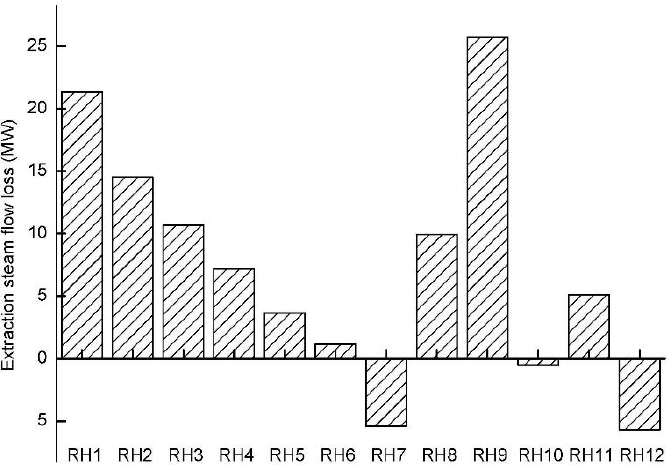
Figure 6. Extraction steam working increase.